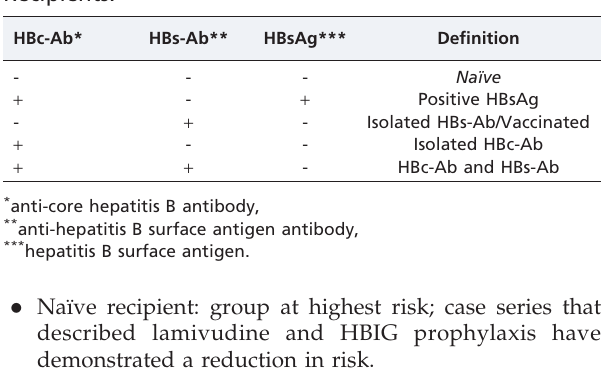
Table 2 - Definitions of HBV serologic profiles –